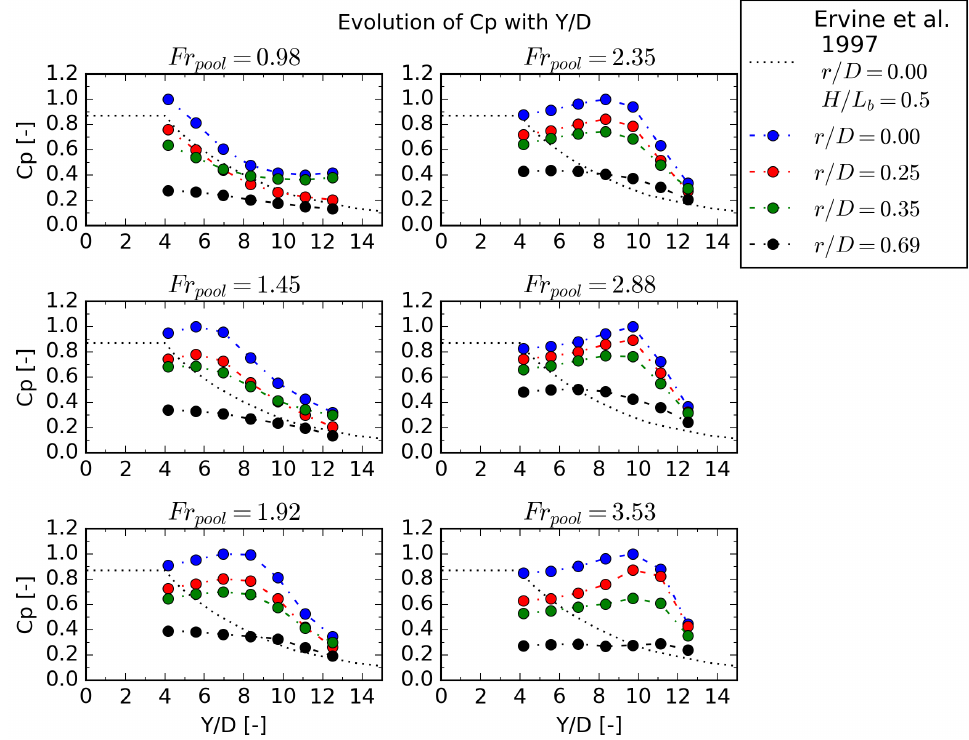
Figure 5. Mean dynamic pressure coefficient Cp [-] as a function of the pool depth ratio Y / D —at a radial distance r / D = 0.00–0.25–0.35–0.69—Jet break-up length ratio H / L b ≤